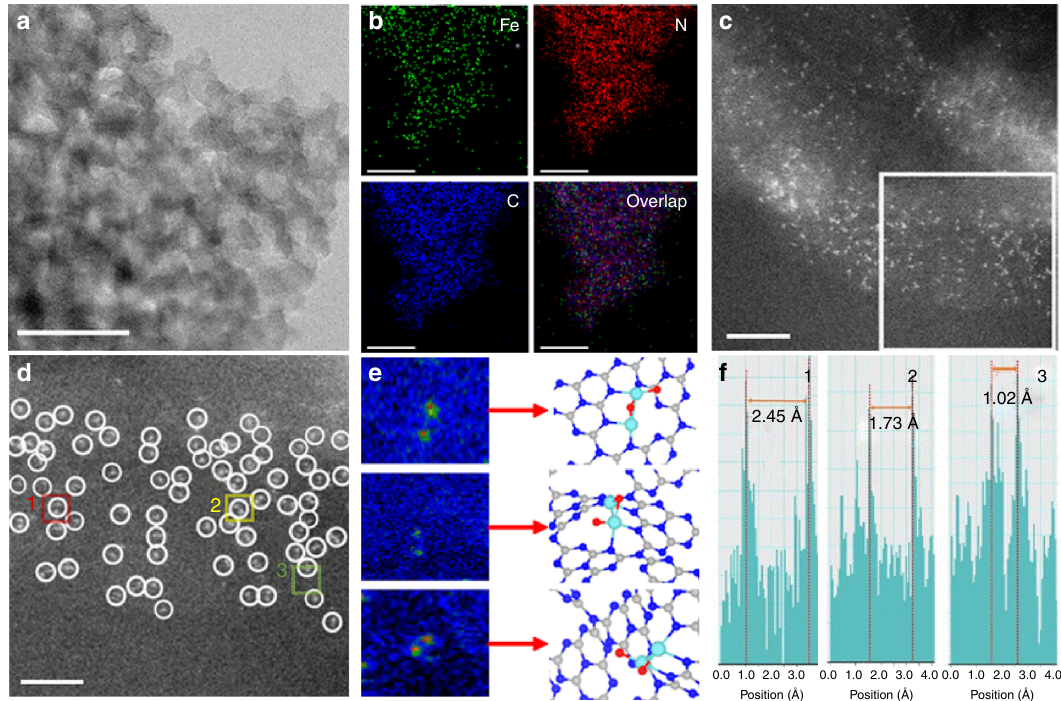
Fig. 1 Characterization of Fe 2 /mpg-C 3 N 4 clusters. a HAADF-STEM images of Fe 2 /mpg-C 3 N 4 . Scale bar, 50 nm. b Corresponding element maps showing distributions of Fe (green), N (red), and C (blue), respectively. Scale bar, 50 nm. c AC HAADF-STEM images of Fe 2 /mpg-C 3 N 4 . Scale bar, 2 nm. d Magni fi ed AC HAADF-STEM images of Fe 2 /mpg-C 3 N 4 . Scale bar, 1 nm. e , f Intensity pro fi les obtained in areas 1, 2, and